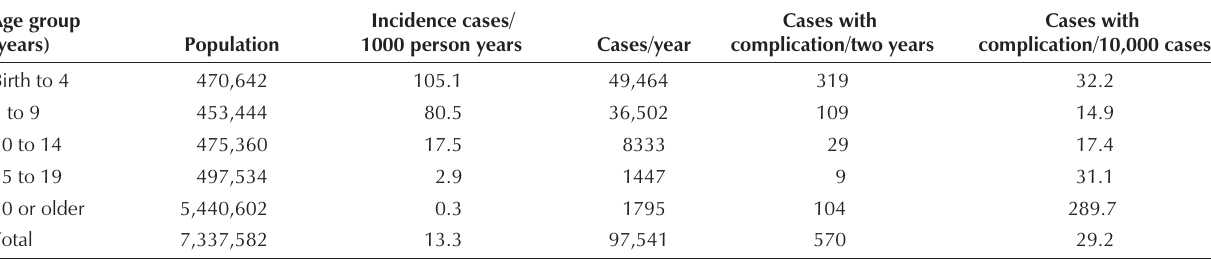
Risk of complications from varicella infection, Quebec, April 1994 to March